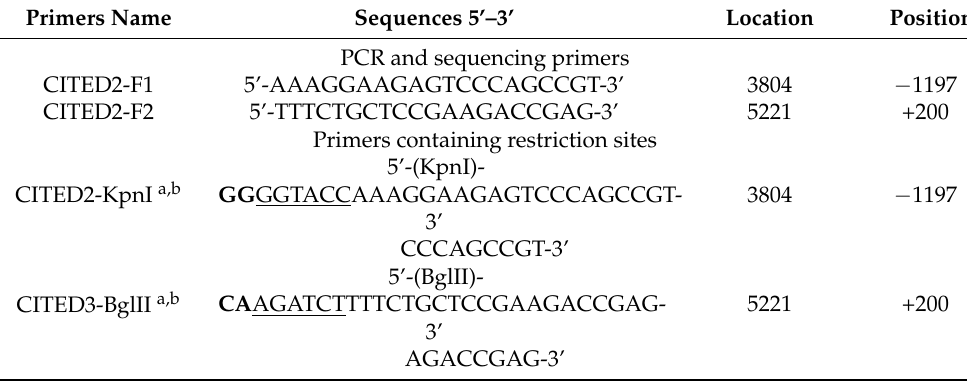
Table 1. Primers used in this study.